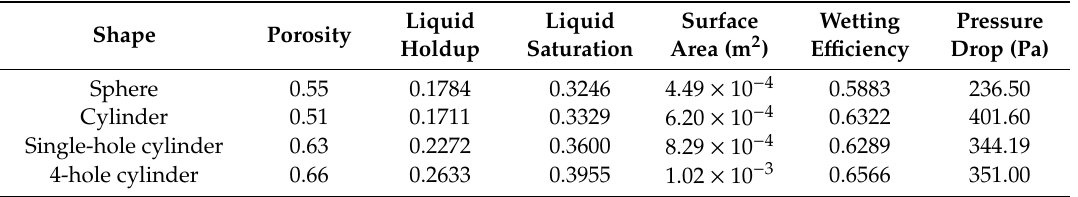
Table 4. Characteristic data of four kinds of random packing